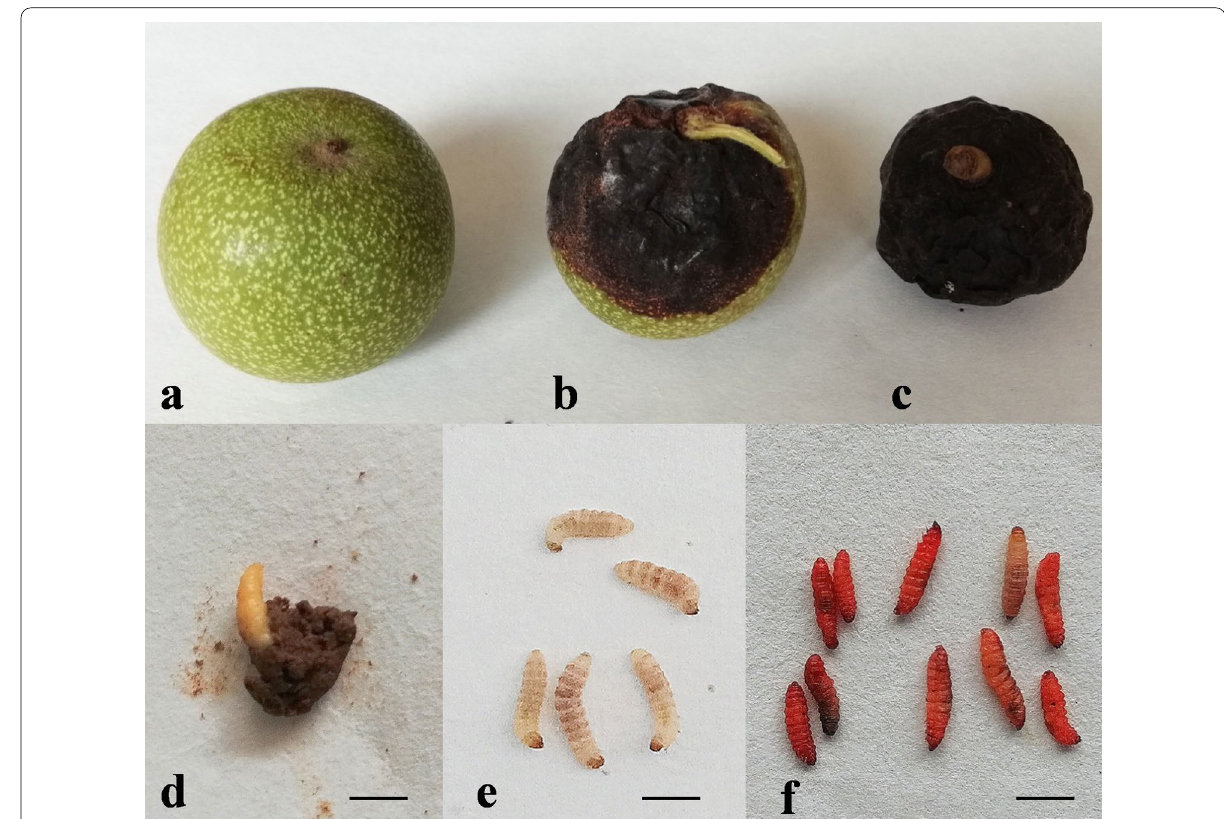
Fig. 2 Symptoms of the damaged walnut fruit and the dead larvae Atrijuglans hetaohei infected with EPNs. a Healthy walnut fruit; b , c Walnut fruit bored by A. hetaohei larvae; d : Healthy A. hetaohei larvae; e , f Infected larvae of A. hetaohei with Steinernematidae and Heterorhabditidae,